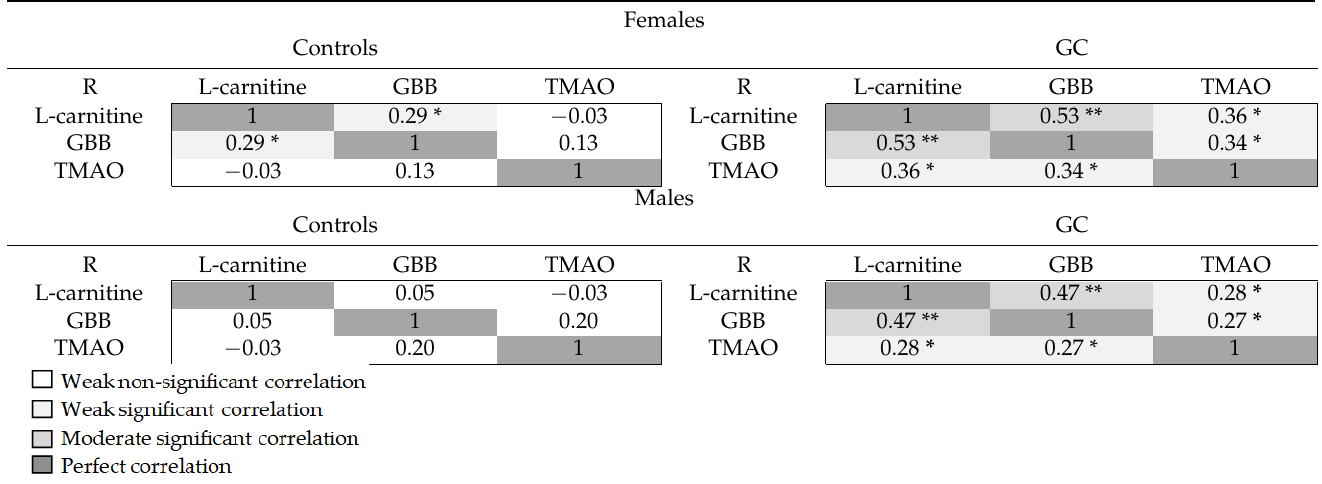
Table 2. Pearson correlation coefficients illustrating correlations between biomarker values L-carnitine, GBB and TMAO in the control group and gastric cancer cases.